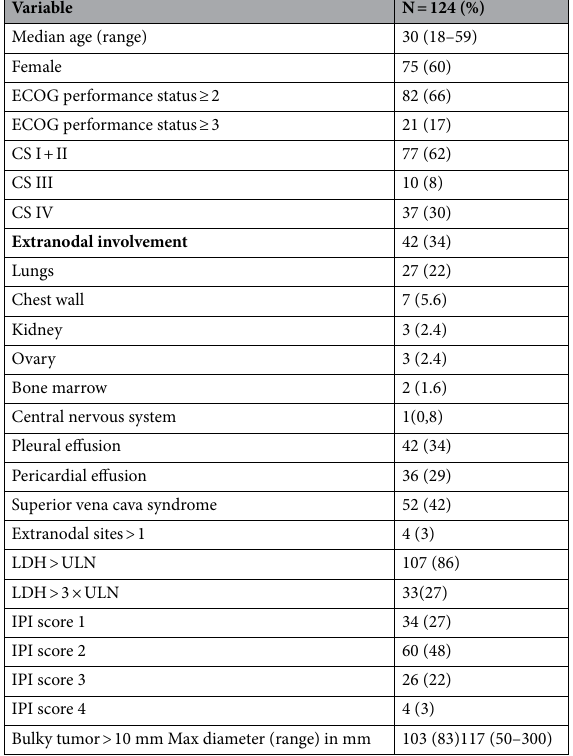
Table 1. Patient characteristics at the diagnosis. LDH dehydrogenase lactate, ECOG Eastern Cooperative Oncology Group, IPI international prognostic index, ULN upper limit of